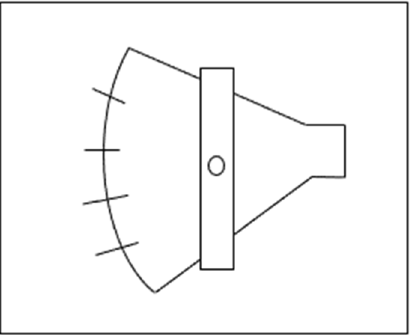
Figure 11. Schematic representation of the 5-CSRTT apparatus. The test is adapted from the rodent version.